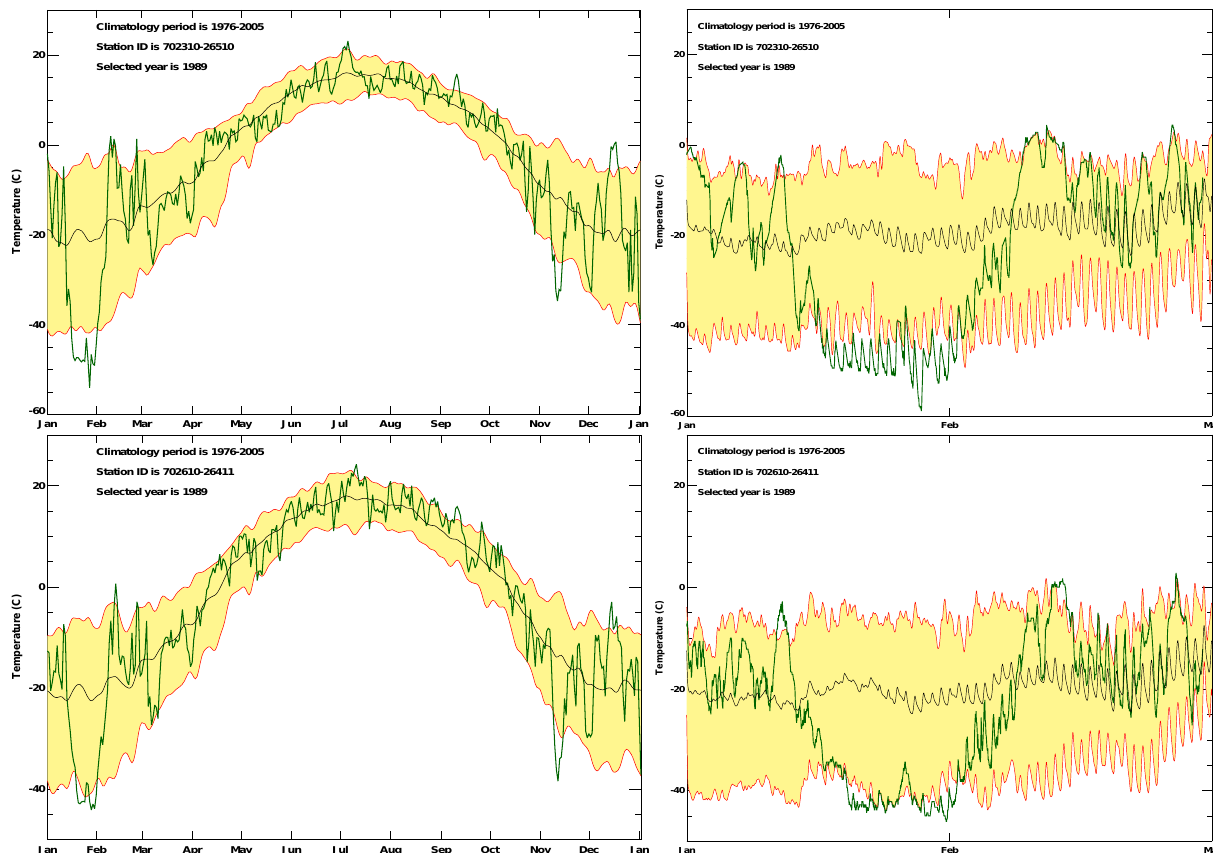
Fig. 18. Left: Alaskan daily mean temperature in 1989 (green curve) shown against the climatological daily average temperature (black line) and the 5th and 95th percentile region, red curves and yellow shading. The cold spell in late January is clearly visible. Right: similar plots, but showing the sub-daily resolution data for a two month period starting in January 1989. The climatology, 5th and 95th percentile lines have been smoothed using an 11-point binomial filter in all four plots. Top: McGrath (702310-99999, 62.95 ◦ N, 155.60 ◦ W, 103m), bottom: Fairbanks (702610-26411, 64.82 ◦ N, 147.86 ◦ W,